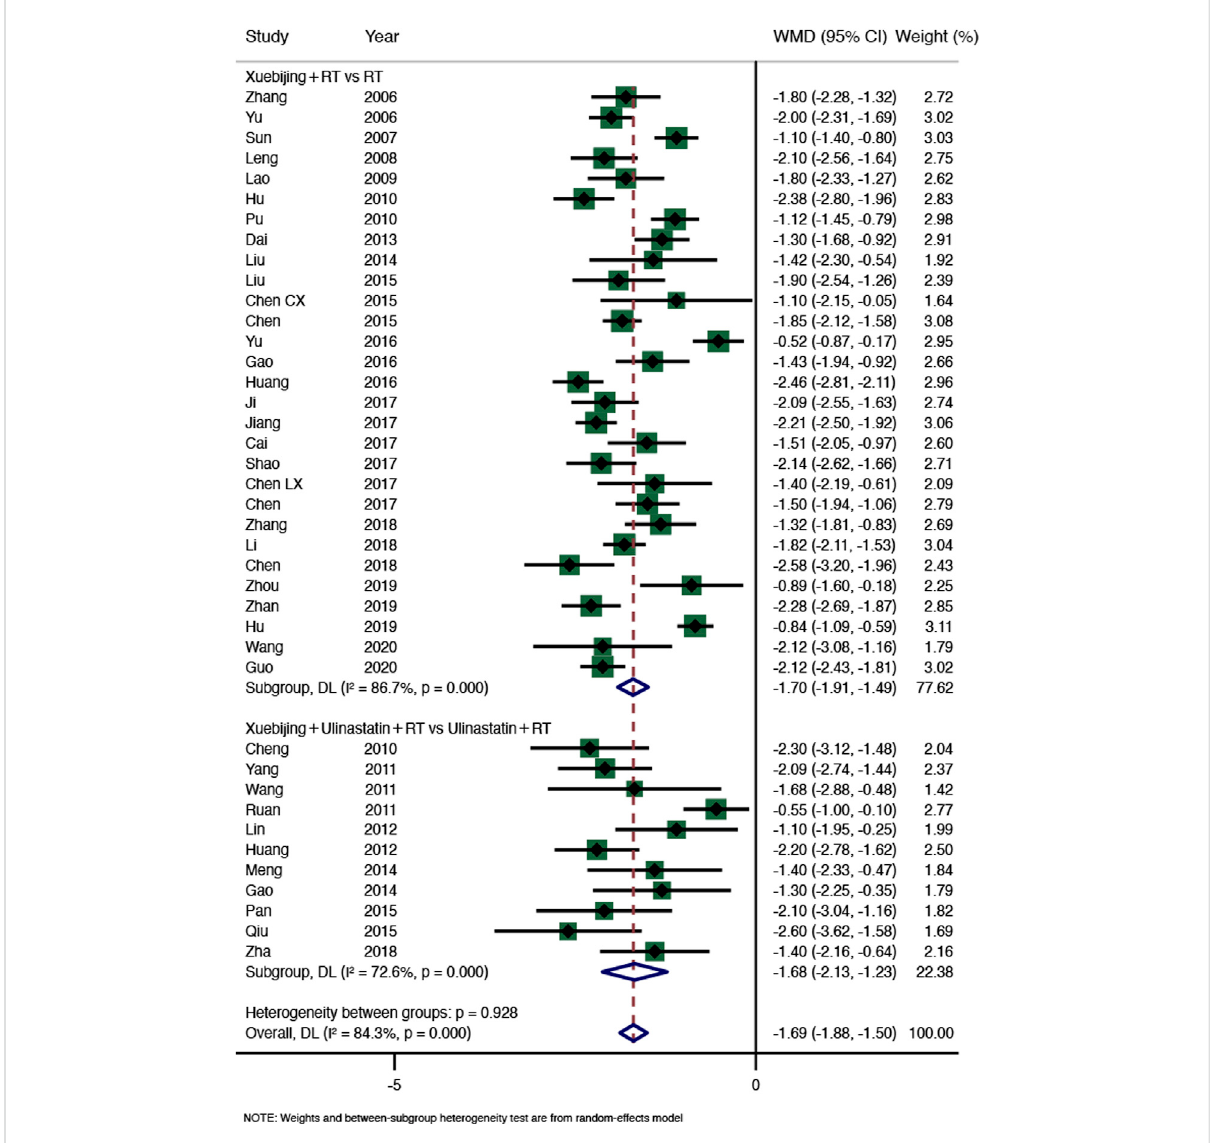
FIGURE 4 Meta-analysis of time until relief of abdominal